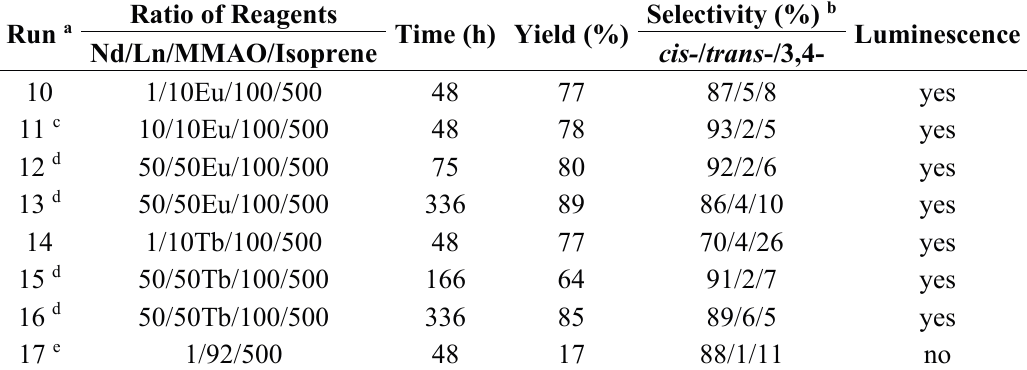
Table 2. Isoprene polymerization using [Nd(form) 3 + Ln(form) 3 ] as pre-catalysts. Ratio of Reagents Selectivity (%) b Run a Time (h) Yield (%) Luminescence Nd/Ln/MMAO/Isoprene cis- / trans